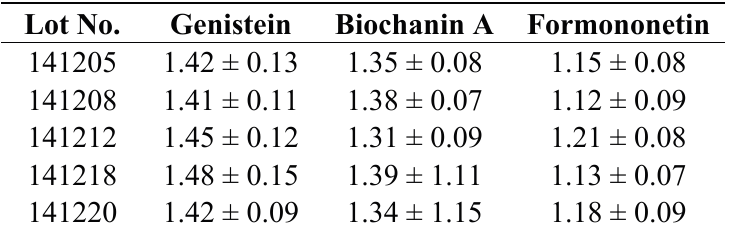
Table 4. Result of content determinition of five samples (mg · g − 1 , n = 5, ⎯ x ± s